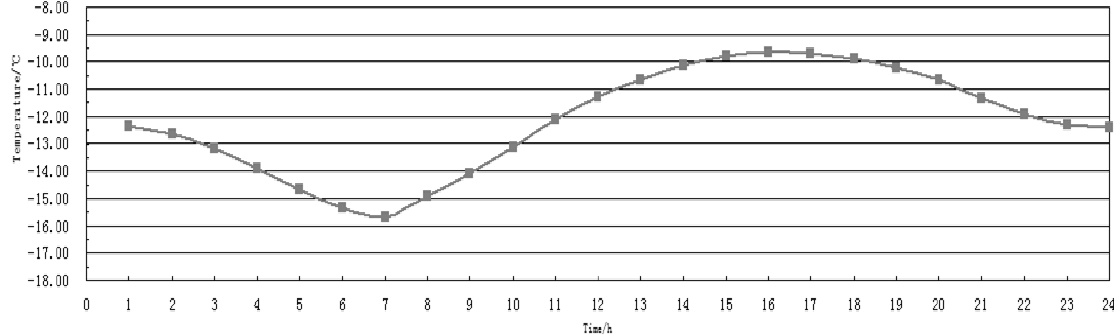
Figure 6. Temperature meteorological model of particular day of disastrous weather in January in Beijing.